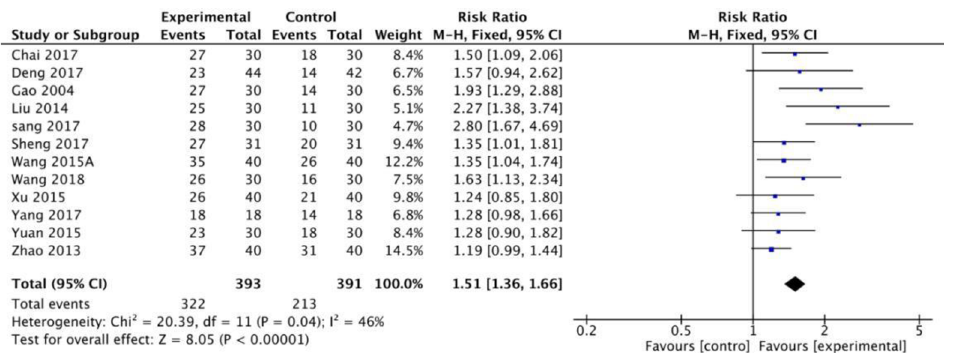
Fig 3. Meta-analysis of fire acupuncture versus acupuncture for spasticity after stroke in ER.